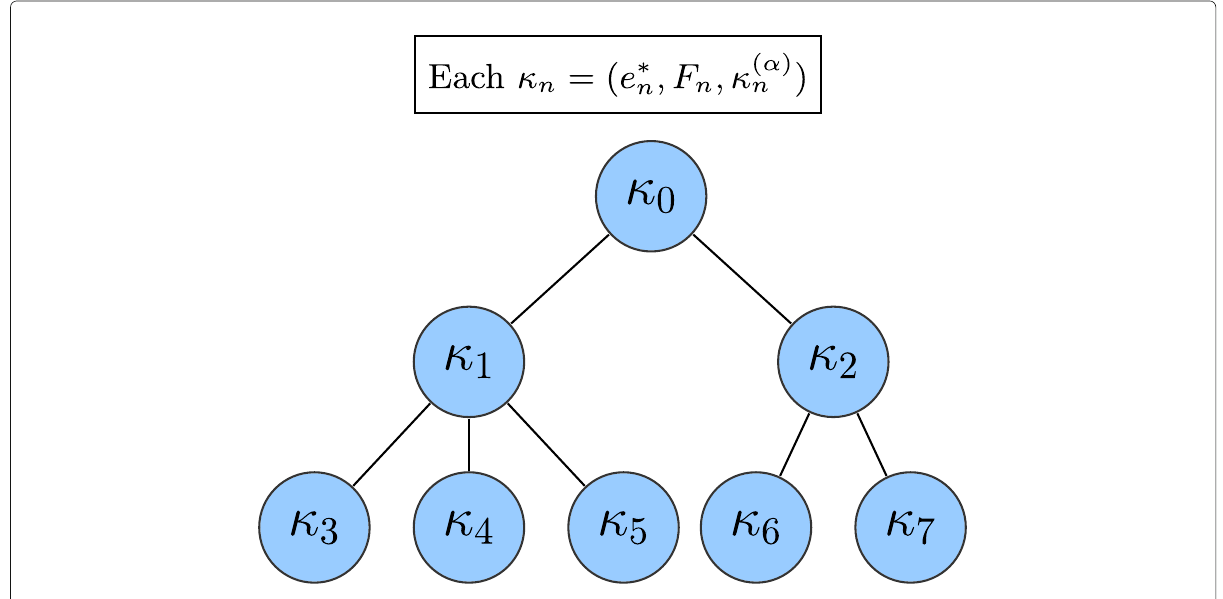
Fig. 3 Representation of an event tree δ